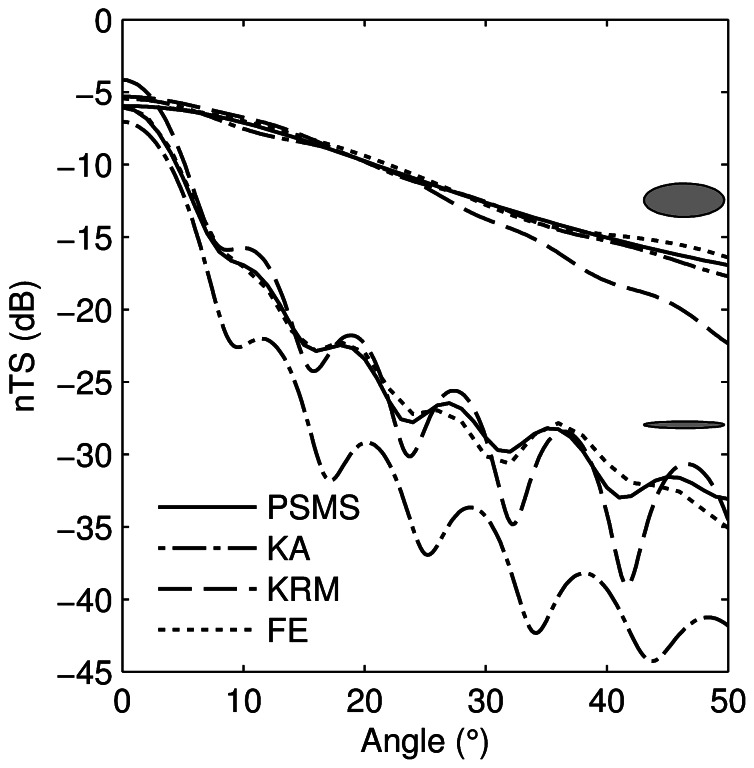
Comparison of model results for two prolate spheroids.Length-normalised target strength (nTS) of a prolate spheroid with ka  = 12 and kb  = 5 (upper curves) and ka  = 12 and kb  = 1 (lower curves) as a function of angle off broadside from the prolate-spheroid-modal-series (PSMS), Kirchhoff-approximation (KA), Kirchhoff-ray-mode (KRM), and finite element (FE) models, where a is the semi-major axis and b the semi-minor axis of the prolate spheroid. The shaded ellipses show the relative shapes of the prolate spheroids.